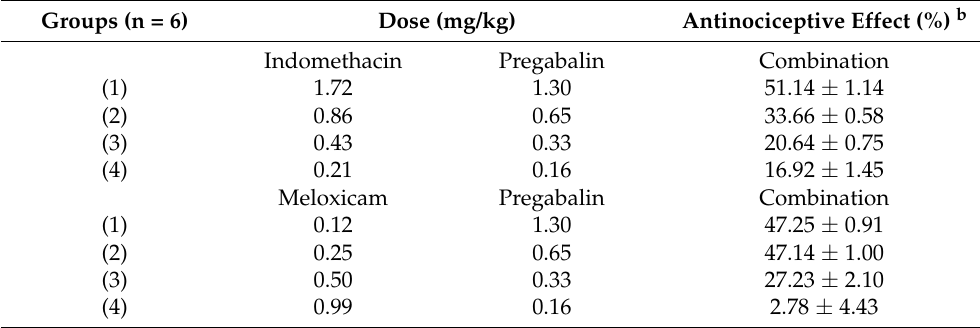
Table 2. Dosages of indomethacin or meloxicam combined with pregabalin in carrageenan-induced inflammatory pain in